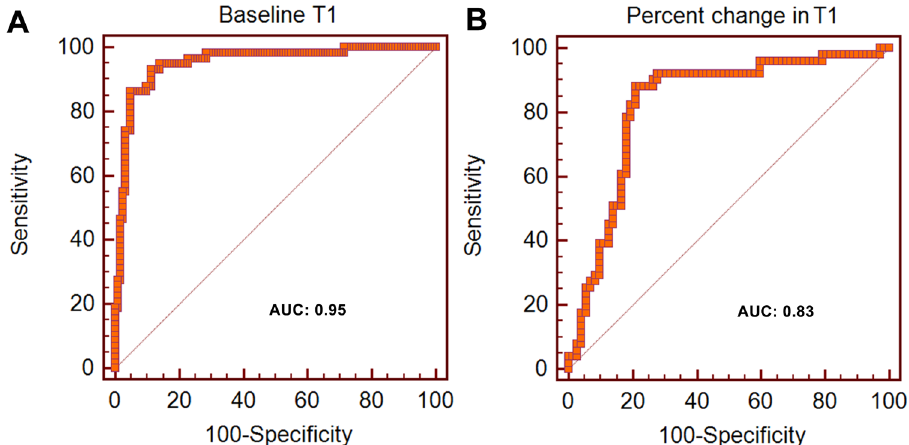
Figure 5. Receiver operating characteristic (ROC) curve analysis for distinguishing myocardial infarction ( A ) and ischemia ( B ) based on resting T1 and T1 reactivity (ΔT1 in %) during stress. AUC = Area under the